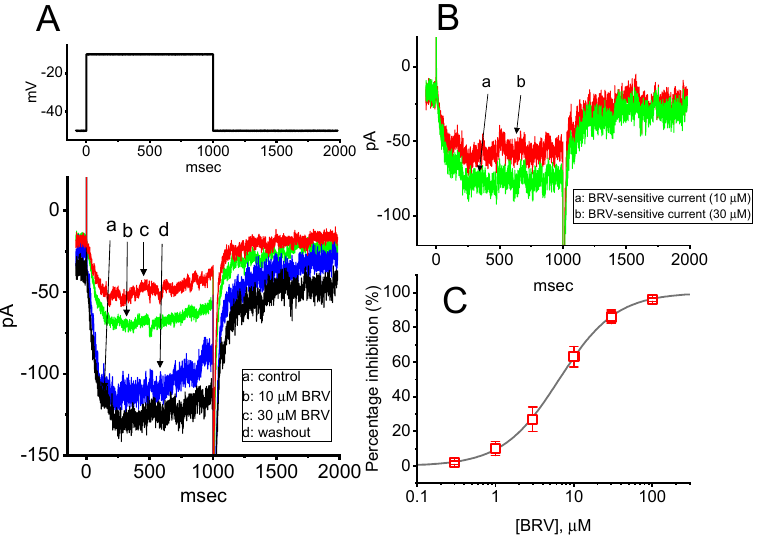
Figure 1. Inhibitory effect of BRV on M-type K + current ( I K(M) ) in GH 3 cells. In these experiments, cells were immersed in high-K + , Ca 2+ -free solution, and the recording electrode was filled with the K + -containing solution comprising: K-aspartate 130 mM, KCl 20 mM, MgCl 2 1 mM, Na 2 ATP 3 mM, Na 2 GTP 0.1 mM, EGTA 0.1 mM, and HEPES 5 mM adjusted to pH 7.2 with KOH; ( A ) Representative I K(M) traces evoked by a 1 s depolarizing pulse from − 50 to − 10 mV (indicated in the upper part of the figure). (a): control (i.e., BRV was not present); (b): 10 µ M BRV; (c): 30 µ M BRV; (d): washout of BRV. It should be noted that the trajectories of the deactivating currents were partly cut off for the purpose of illustration; ( B ) BRV-sensitive inward current (a–b (green trace) or a–c (red trace) in panel ( A )) (a): BRV-sensitive current at 10 µ M BRV; (b): BRV-sensitive current at 30 µ M BRV; ( C ) Concentration-dependent inhibition of BRV on I K(M) amplitude measured from GH 3 cells (mean ± SEM; n = 8). Current amplitude obtained in the absence and presence of different BRV concentrations (0.3–100 µ M) was taken at the endpoint of depolarization pulses ranging from − 50 to − 10 mV. A smooth, continuous line was obtained by fitting the experimental results to the modified Hill equation (as elaborated in the Materials and Methods section). The vertical broken line points out the IC 50 value (i.e., 6.5 µ M) needed for BRV-mediated inhibition of I K(M) in these